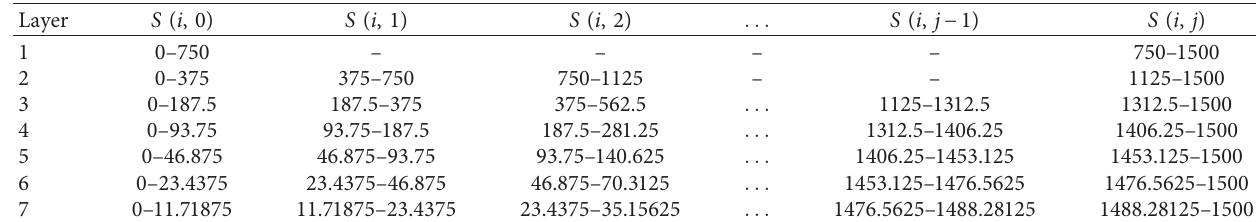
Figure 10: Wavelet function and scaling function for db7. Table 5: The frequency band range of reconstructed signal by wavelet packet decomposition.